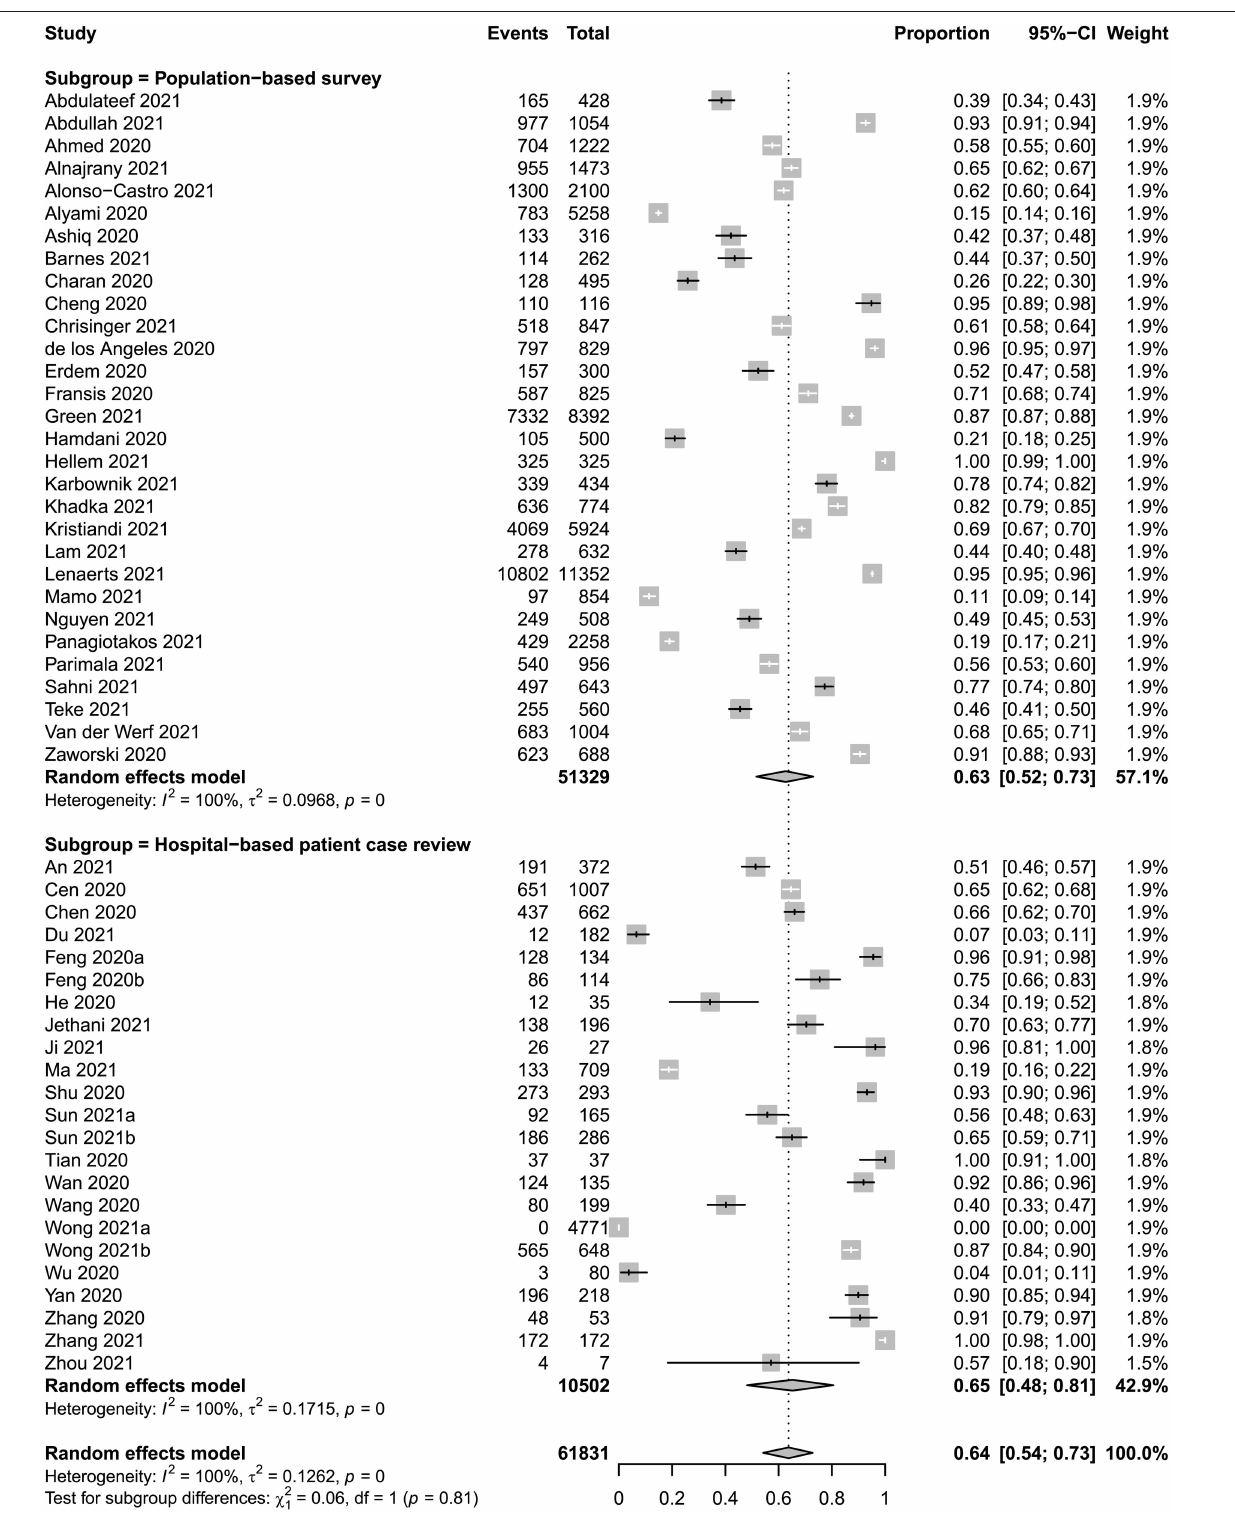
FIGURE 2 | Meta-analysis of overall usage prevalence of TCIM